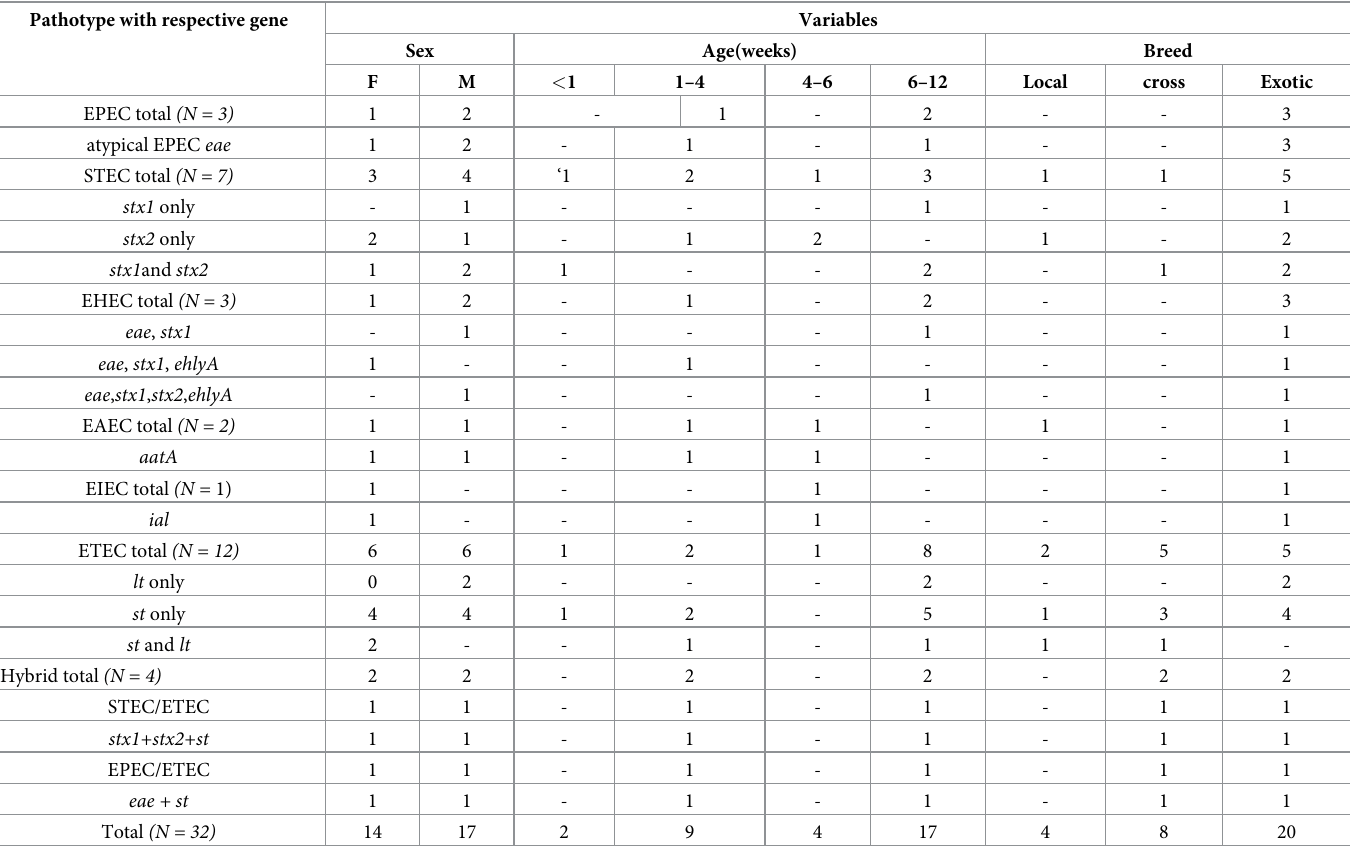
Table 5. Distribution of DEC pathotypes with clinical features and risk factors in diarrheic calves. Pathotype with respective